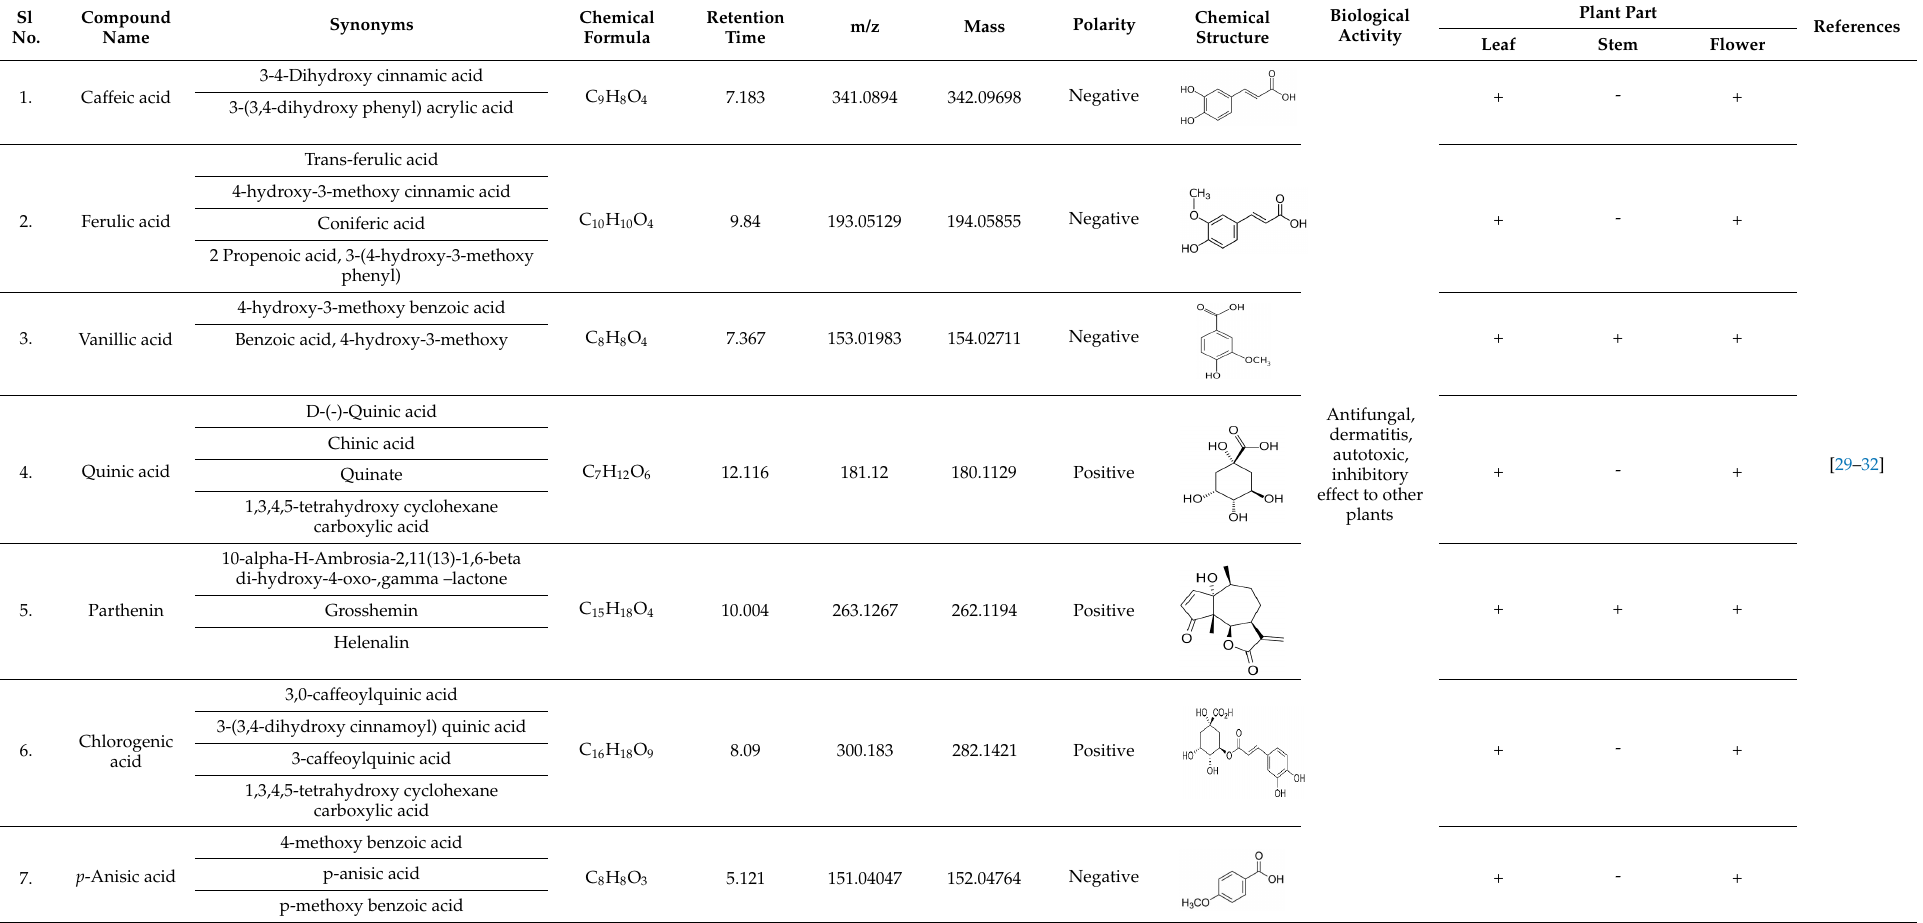
Table 1. Phenolic derivatives found in methanol extract of different parts of Parthenium hysterophorus through LC-MS analysis. Sl